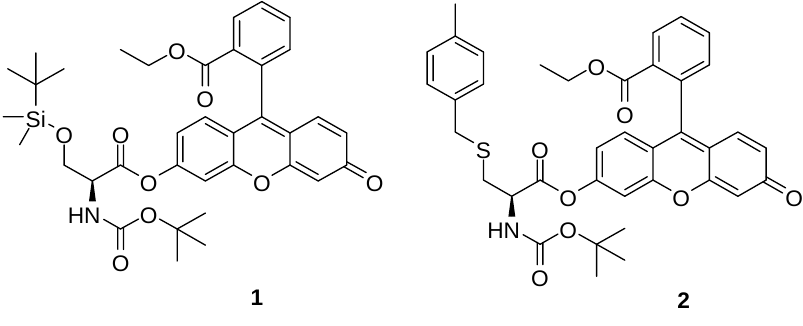
Figure 1. Chemical structure of compounds 1 and 2